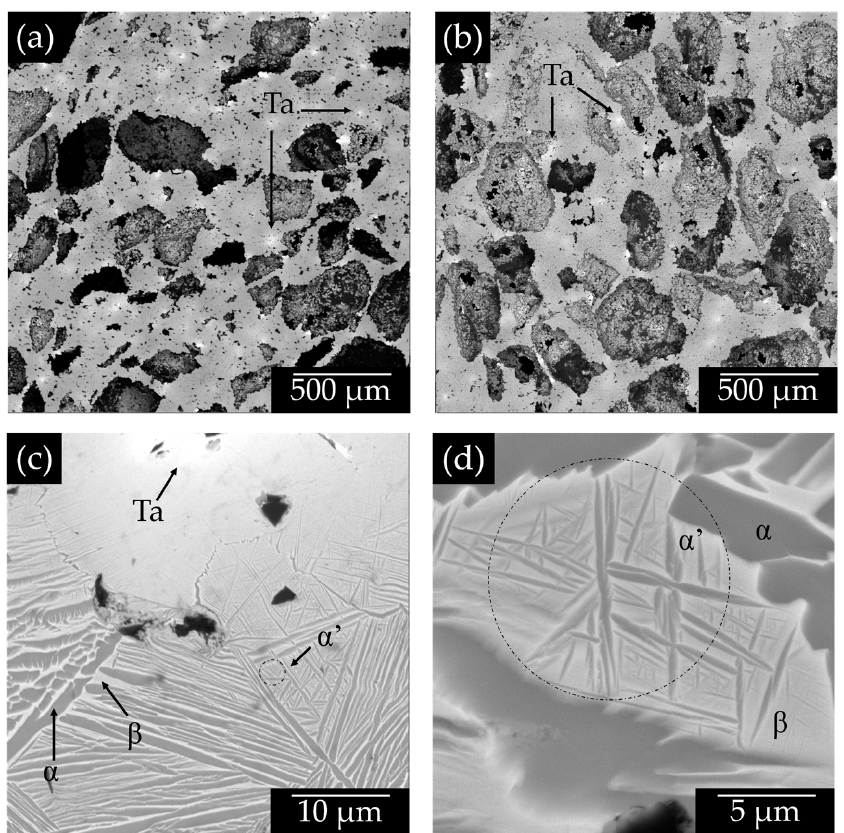
Figure 5. TSEM micrographs of the different Ti-xTa samples with ( a ) 0%; ( b ) 20 wt.%; ( c ) 25 wt.%; and ( d ) 30 wt.%.